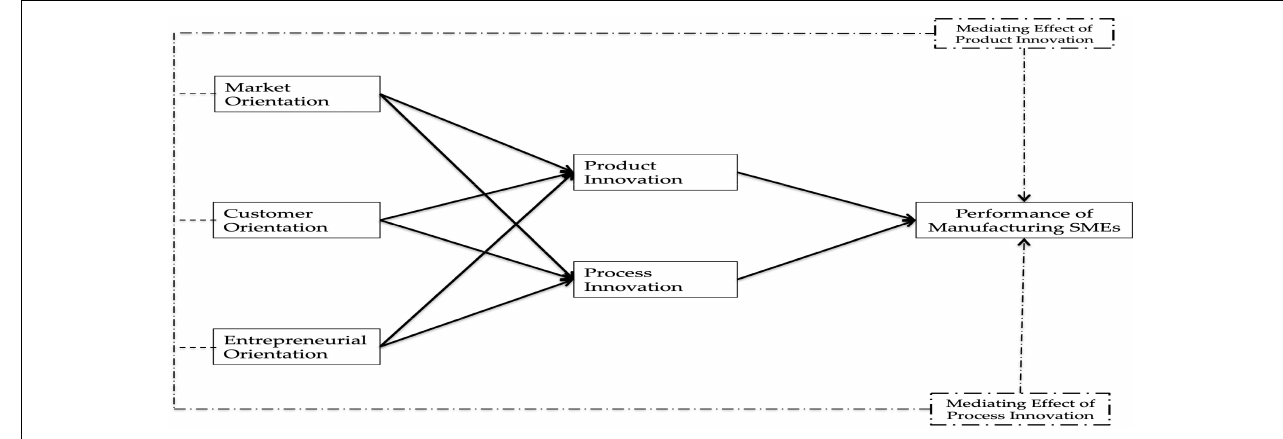
FIGURE 1 | Research